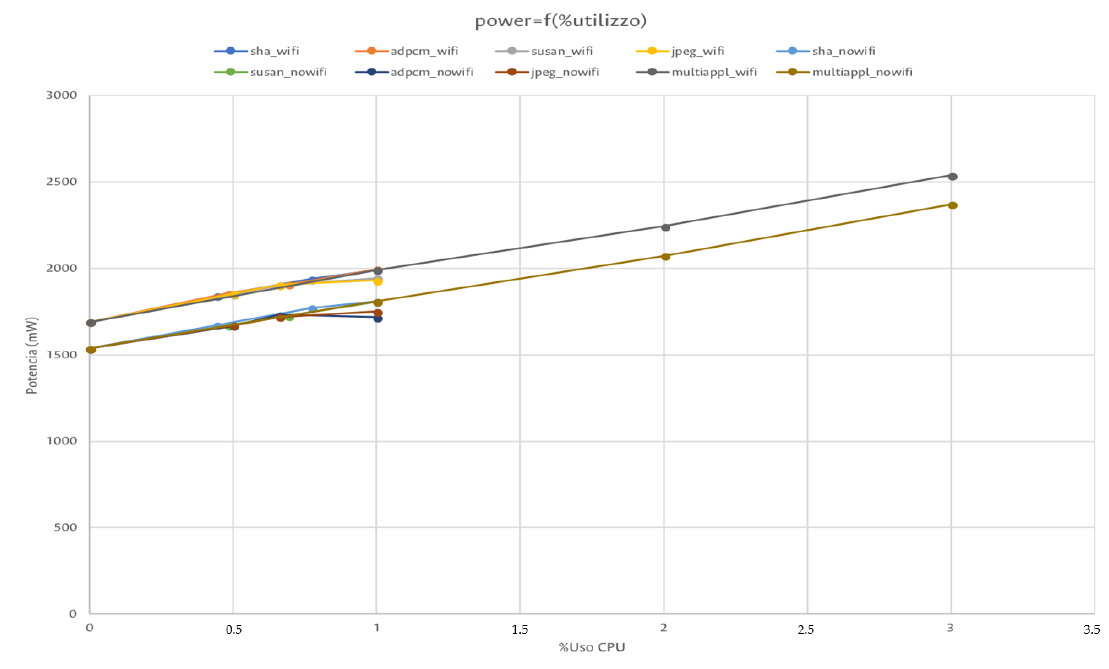
Figure 7. Experiment Model. Table 5. Power Consumption RPI 3 + Table 4. Test Ad hoc-batctl/batman-adv RPi 3.